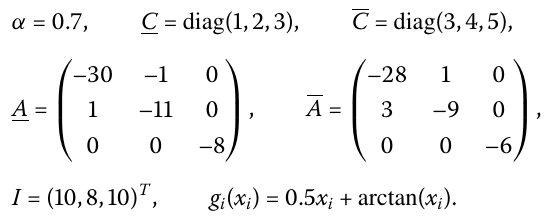
Figure 3 The state trajectory x of neural network (17) in Case 3 of Example